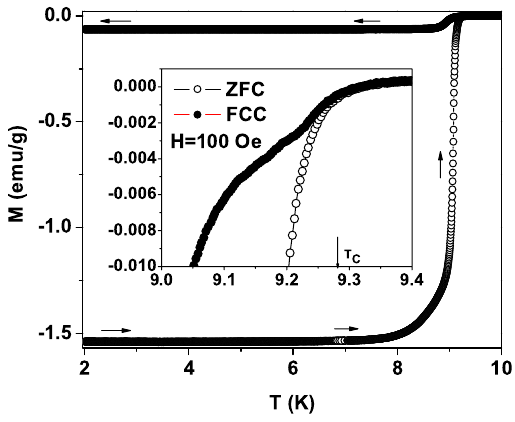
FIG. 5. M versus T plot for electron beam welded and electro- polished niobium step joint in an applied field of 100 Oe. The inset highlights the temperature region near T C